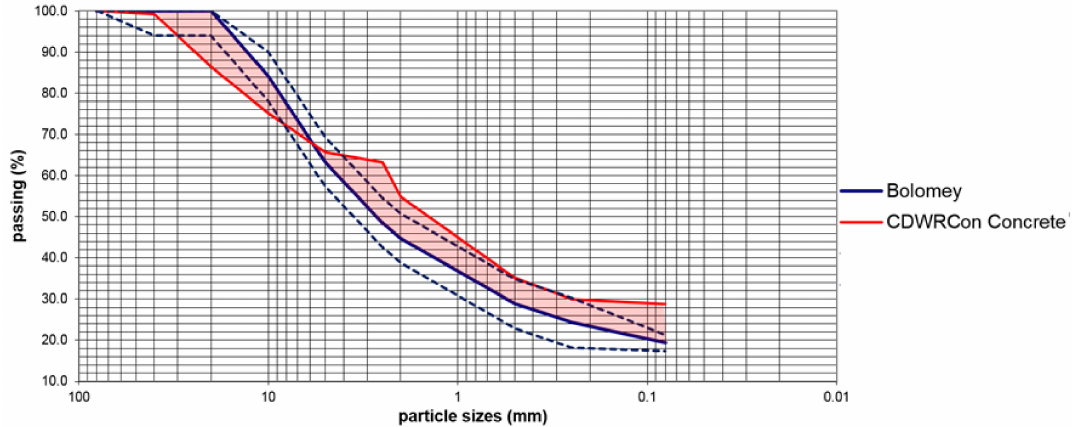
Figure 2. CDWRCon versus Bolomey granulometric curves.